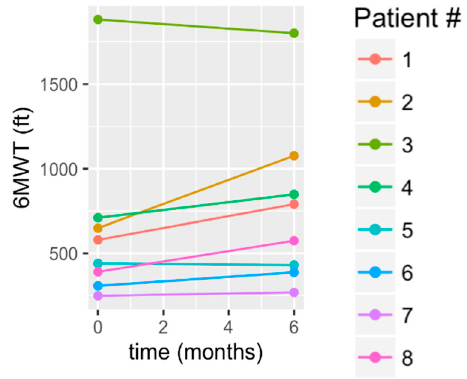
Figure 4. Change in 6 min walk test (6MWT) from baseline to 6 months.